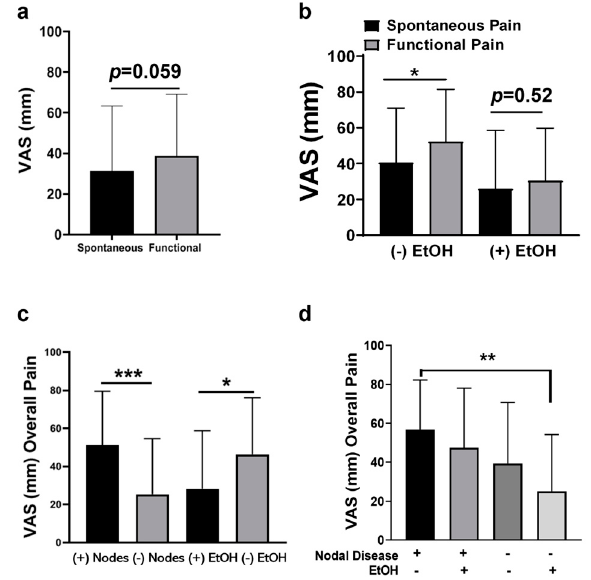
Figure 3. ( a ) VAS scores for spontaneous (Q1) pain vs. functional pain (Q2). ( b ) VAS scores for spontaneous (Q1) pain vs. functional pain (+/-) EtOH consumption. ( c ) VAS scores for overall pain (Q1 and Q2 combined) (+/-) Nodal disease or EtOH consumption. ( d ) VAS scores for overall pain (+/-) EtOH consumption and nodal disease. * p < 0.05, ** p < 0.01, and ***p<0.001.